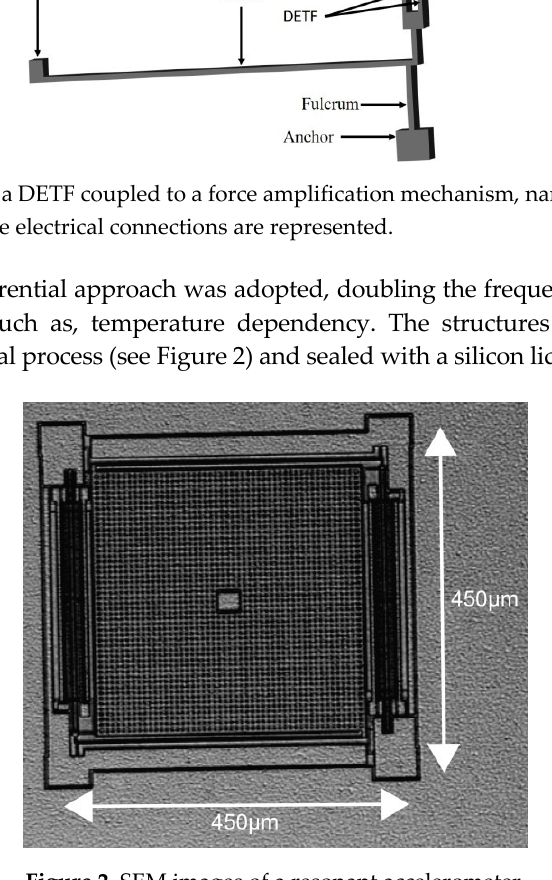
Figure 2. SEM images of a resonant